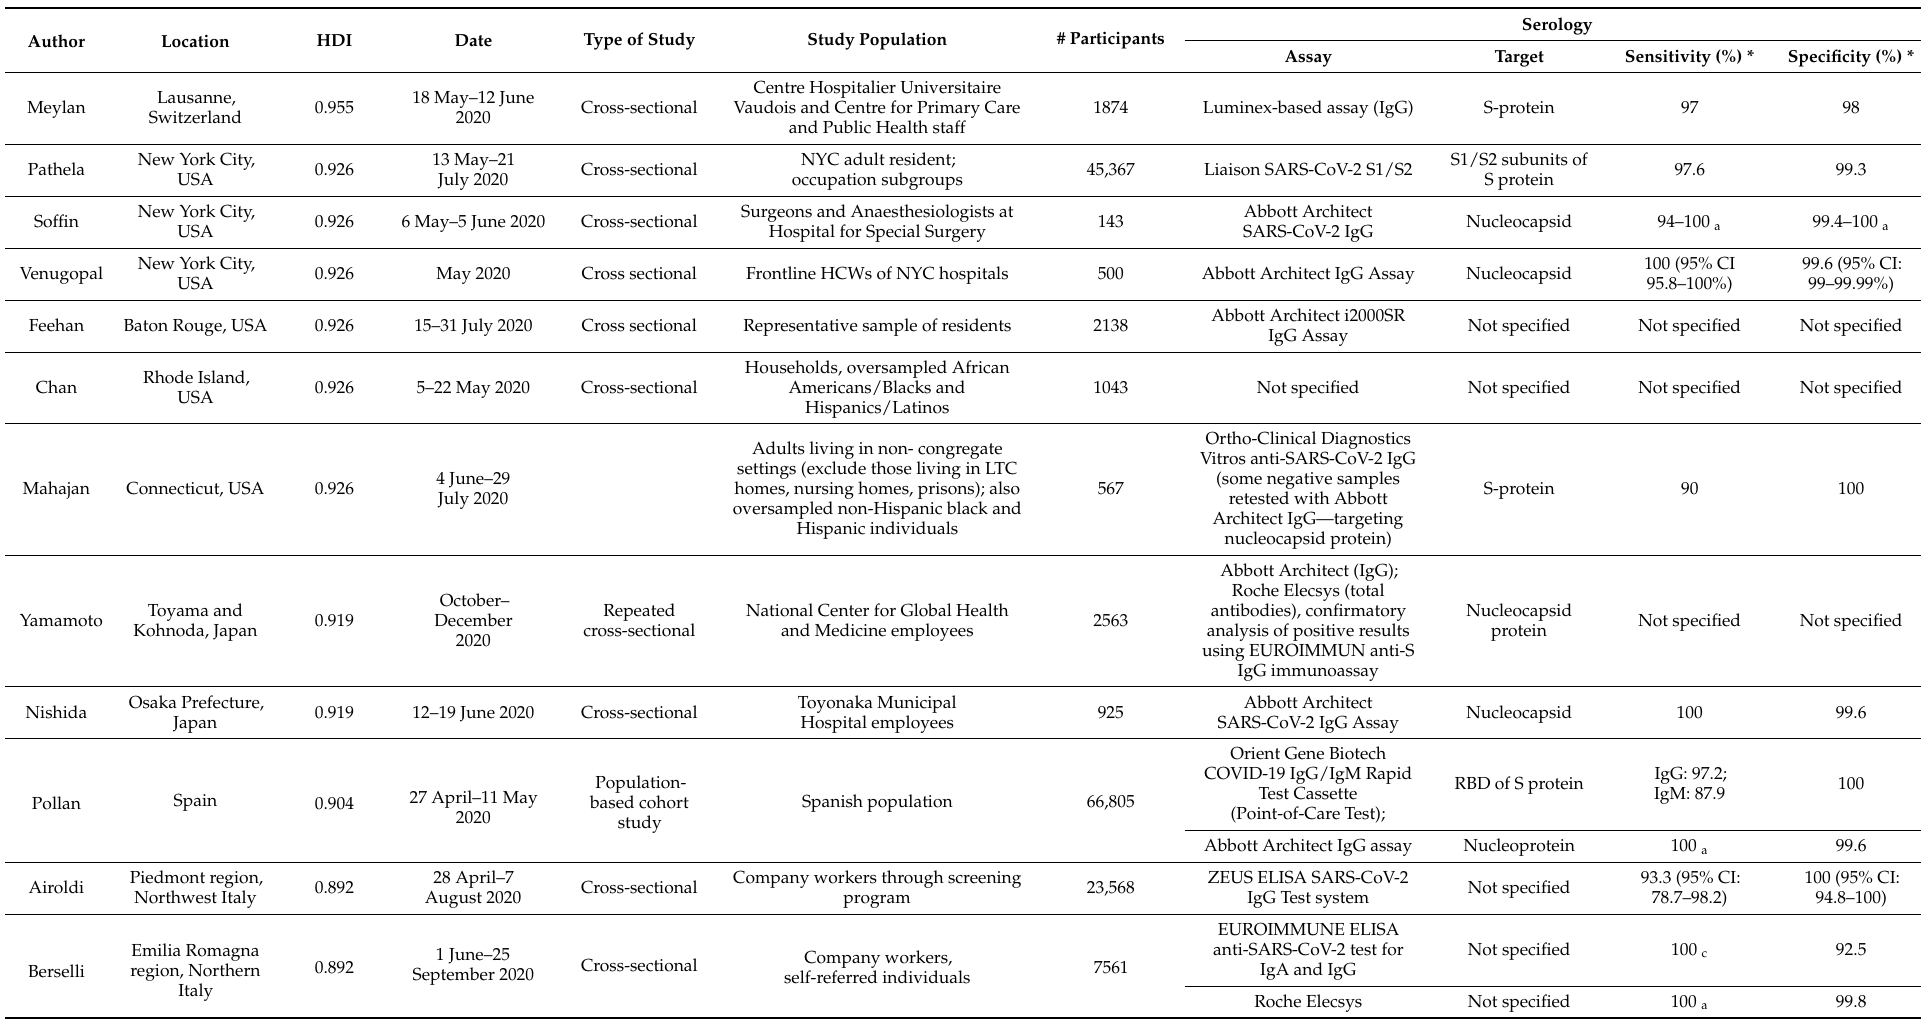
Table 1. Characteristics of included studies from highest to lowest